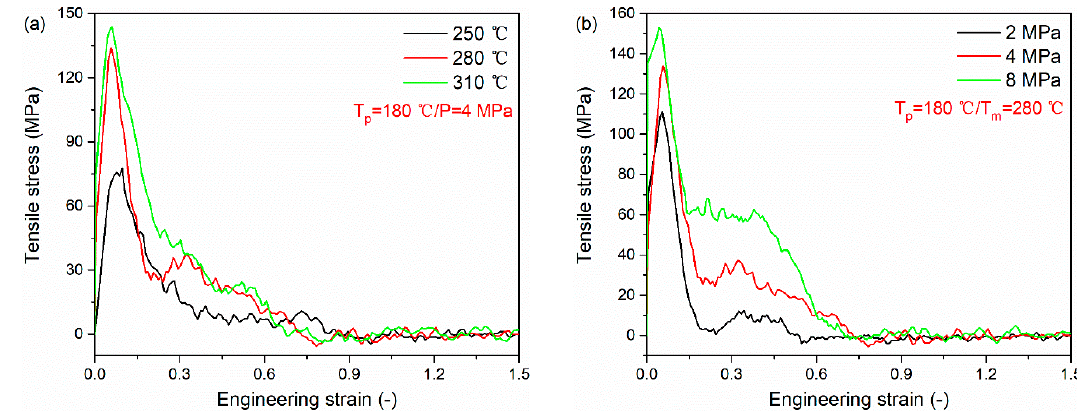
Figure 9. Tensile stress versus engineering strain curves for PA66–PP interface under various processing parameters: ( a ) melting temperatures and ( b ) injection pressure. Table 3. Mechanical properties of PA66–PP interface under various TCO processing parameters.